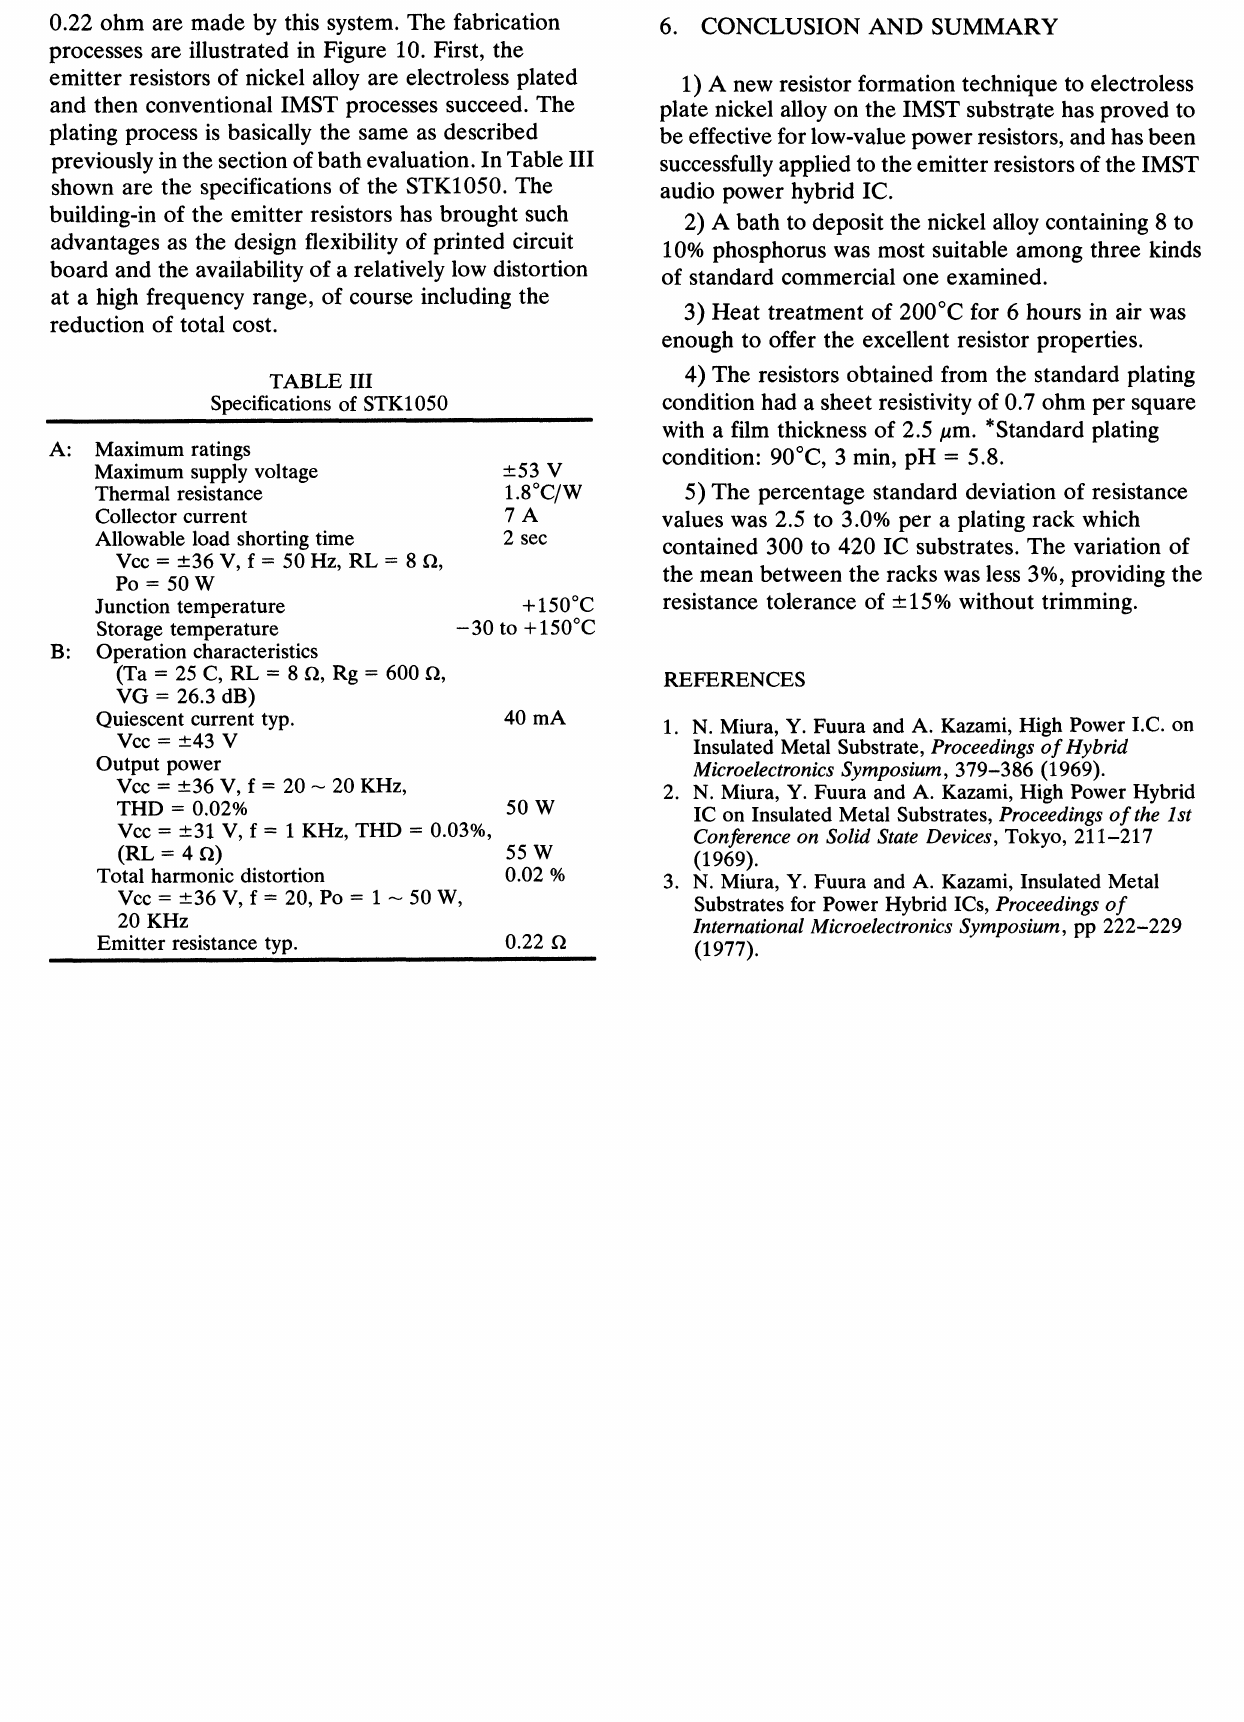
TABLE III Specifications of